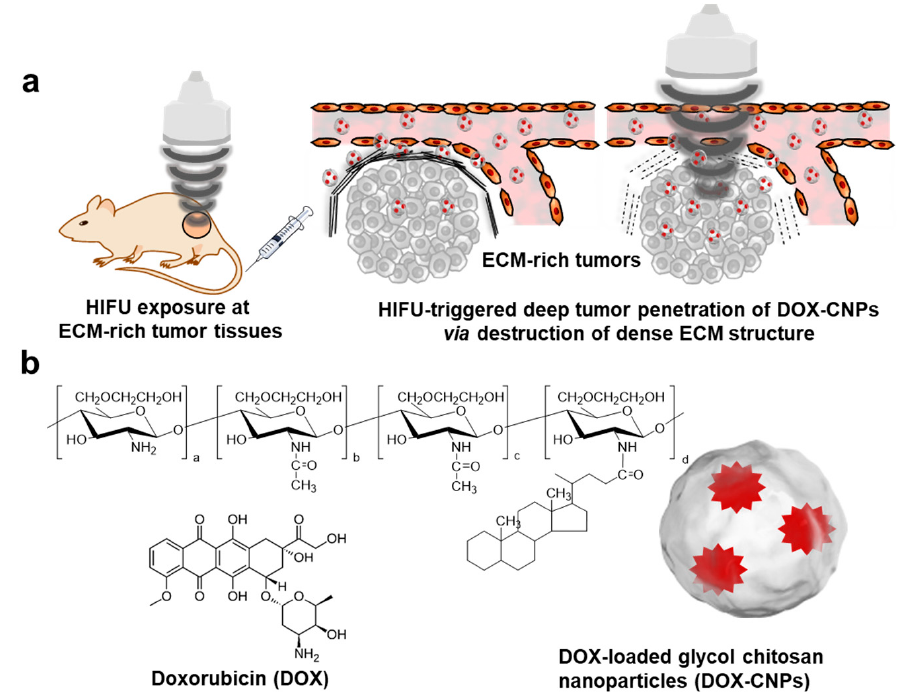
Figure 1. ( a ) High-intensity focused ultrasound (HIFU) treatment of doxorubicin (DOX)-loaded glycol chitosan nanoparticles (CNPs) (DOX-CNPs) to increase their deep tumor penetration in extracellular matrix (ECM)-rich tumor models. ( b ) Schematic illustration of glycol chitosan-5 β -cholanic acid conjugate. The glycol chitosan-5 β -cholanic acid conjugates form self-assembled nanoparticles